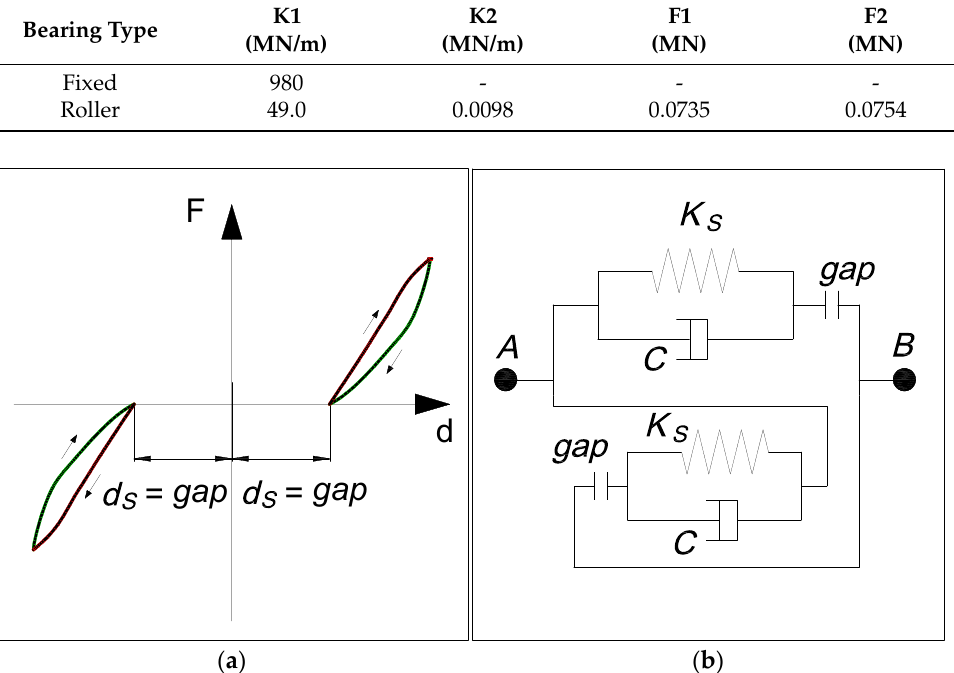
Figure 6. Force–displacement relationships for steel stoppers. ( a ) Modified Hertz-damp model. ( b ) Pounding element model.